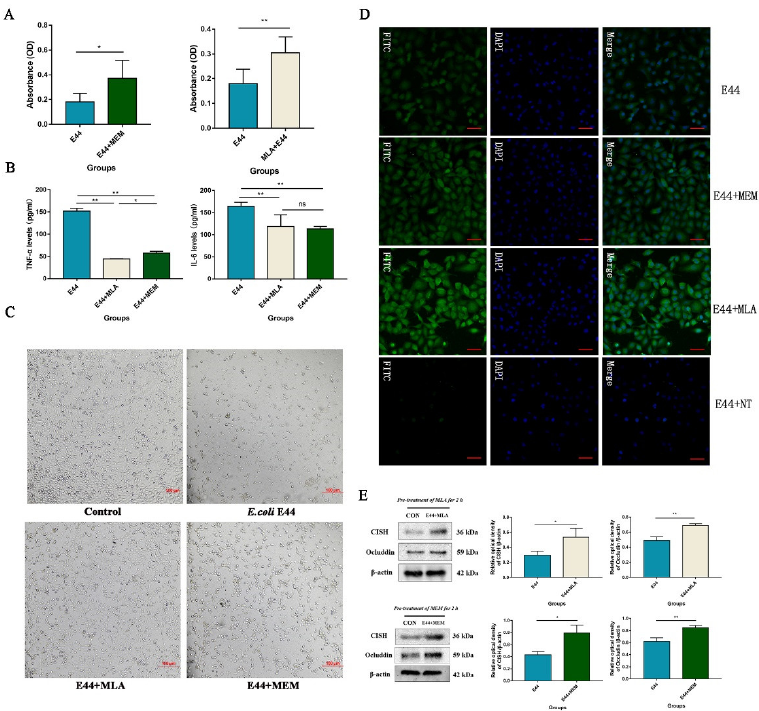
Figure 5. Protective effects and mechanism of MLA and MEM attenuating E. coli -induced HBMEC cell injuries in vitro. ( A ) Cell viabilities of infected HBMEC cells treated with MLA and MEM, detected by CCK-8 assay. ( B ) The expressions of IL-6 and TNF-α in HBMEC cells’ supernatant with MLA, MEM when infected with E. coli E44. ( C ) Morphological observations of infected HBMEC cells pre-treated with MLA and MEM, respectively (200×). ( D ) α7nAChR activation/inhibition on HBMEC treated with MLA, MEM, and NT, detected CISH expression by immunofluorescence assay, respectively, conducted by Axio Imager M2 software (Nikon, JPN). ( E ) The expressions of Occludin, CISH proteins in infected HBMECs treated with MLA, MEM. The expressions of CISH and Occludin in infected HBMEC cells pre-treated with MLA, MEM detected by WB, relative optical density analyzed by Image J. * p < 0.05, ** p < 0.01; ns, no significance.